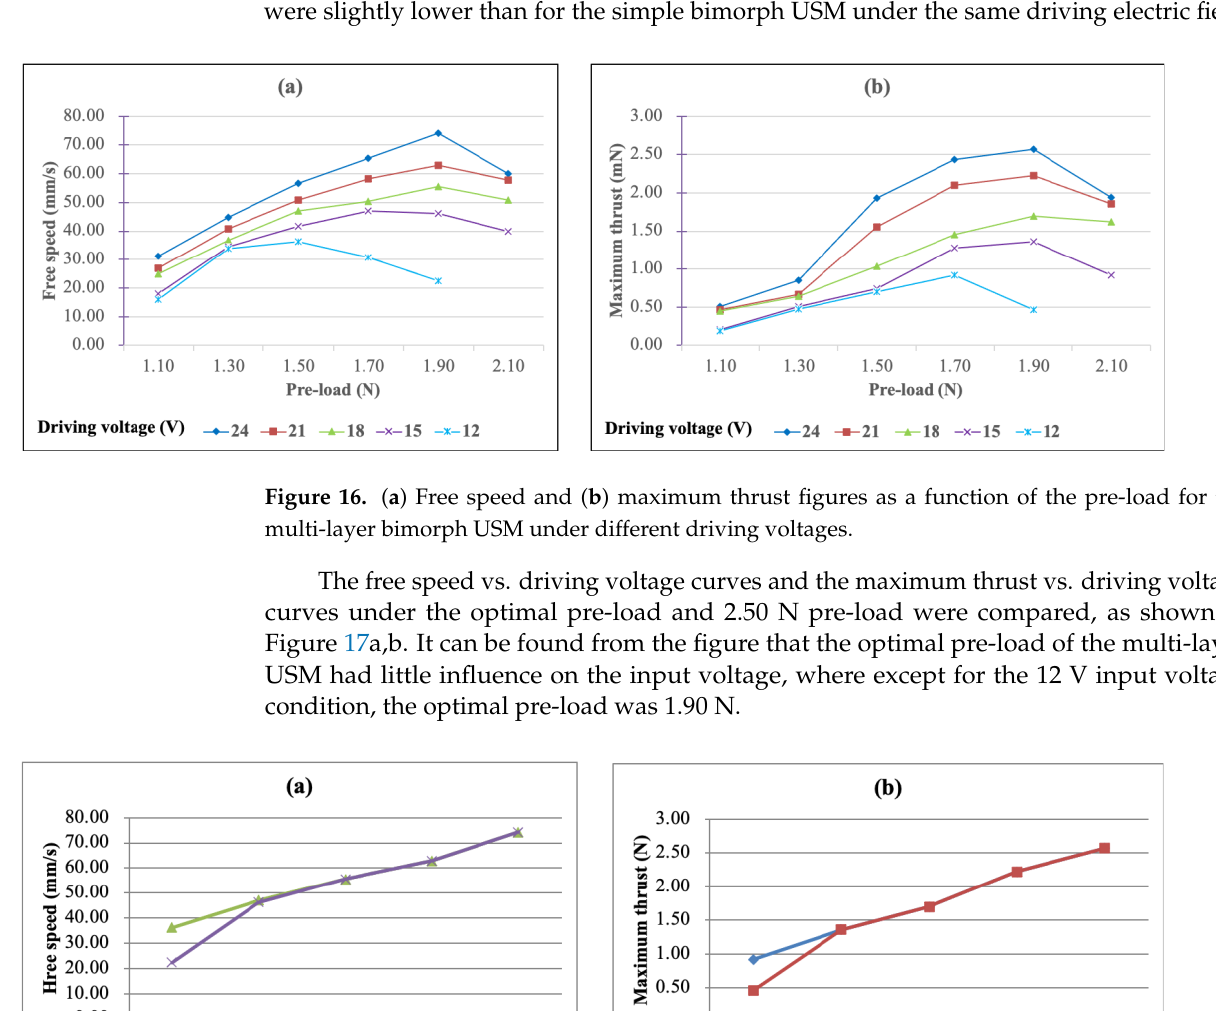
Figure 17. ( a ) Free speed and ( b ) maximum thrust figures as a function of the driving voltage for the multi-layer bimorph USM under different pre-loads.